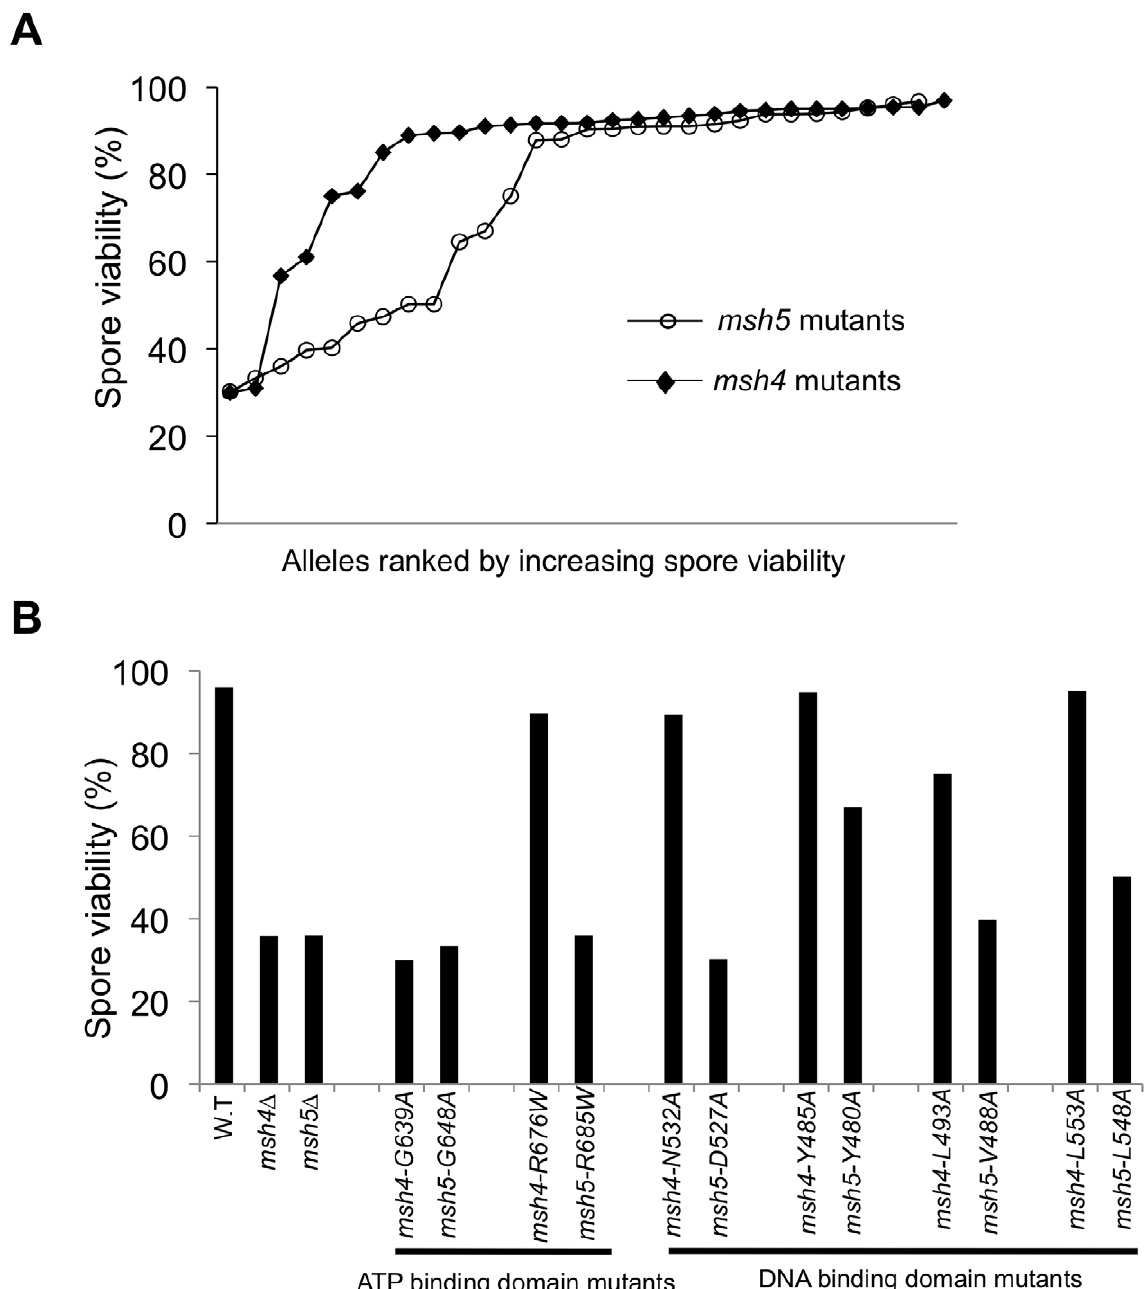
Figure 2. The Msh5 subunit is more sensitive to mutagenesis. (A) Comparison of spore viability of 29 msh4 and 28 msh5 mutants in ascending order in the EAY background. (B) Spore viability of conserved pairs of residues in Msh4, Msh5 ATP binding domain and DNA binding domain. msh4- G639A and msh5-G648A contain mutations analogous to ATP binding mutations in Msh2 while msh4-R676W and msh5-R685W contain mutations analogous to ATP hydrolysis mutations in Msh2. msh4-N532A , msh4-Y485A , msh4-L493A , msh4-L553A , and their matched mutations in Msh5 ( msh5- D527A , msh5-Y480A , msh5-V488A , msh5-L548A ) are conserved within the DNA binding domain (IV). The number of tetrads dissected for each strain is presented in Table